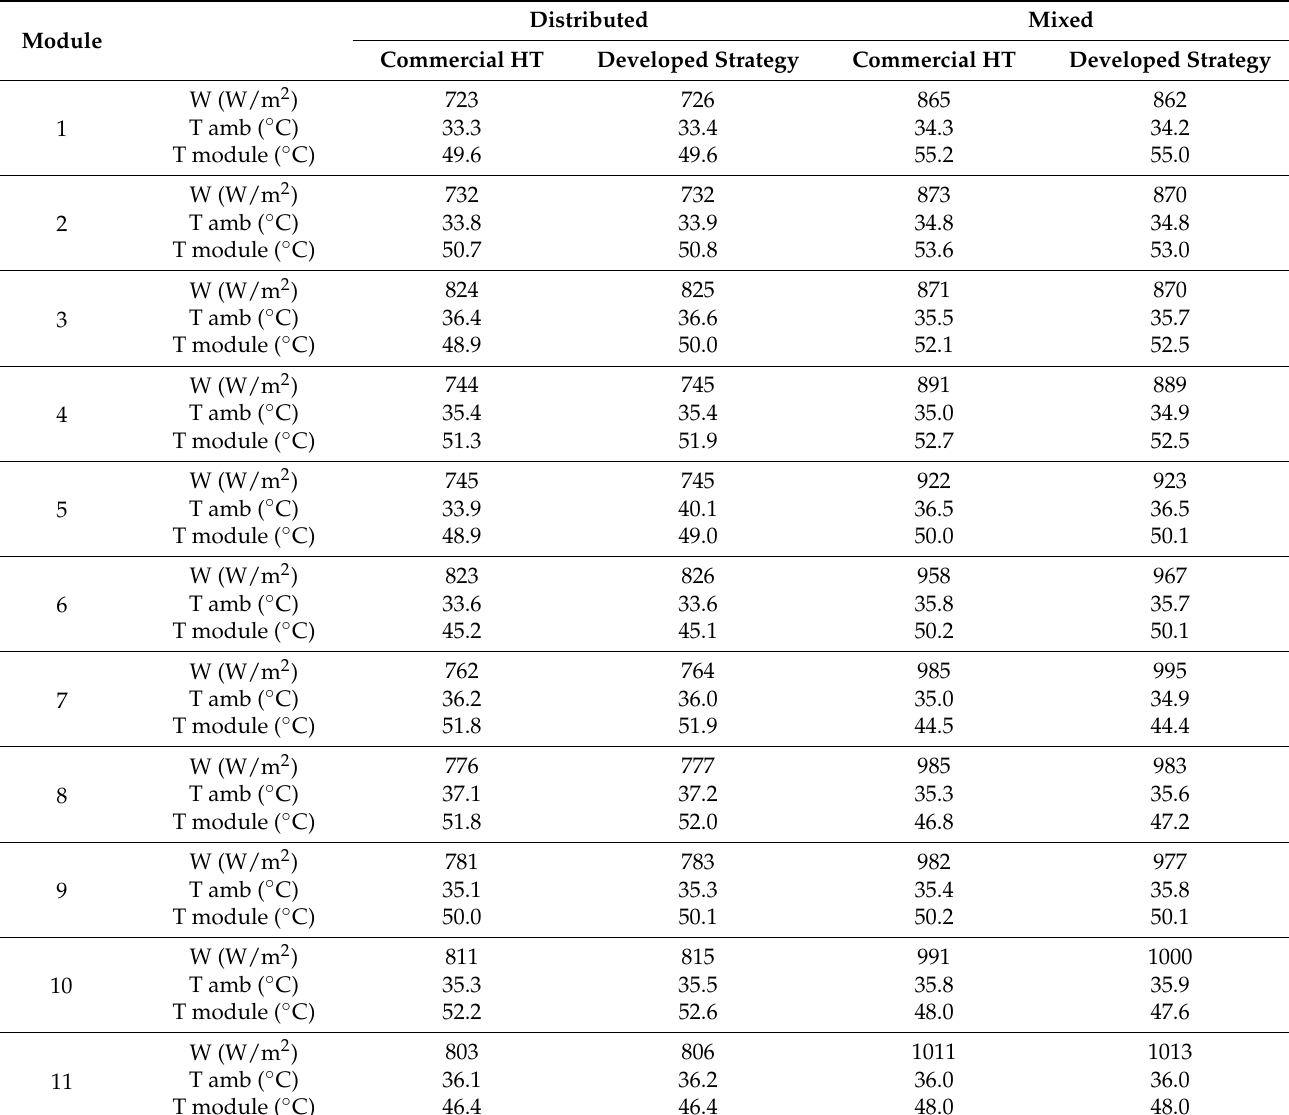
Table 3. Irradiation level, ambient temperature, and module temperature conditions in which the measurements have been taken. Distributed Mixed Module Commercial HT Developed Strategy Commercial HT Developed